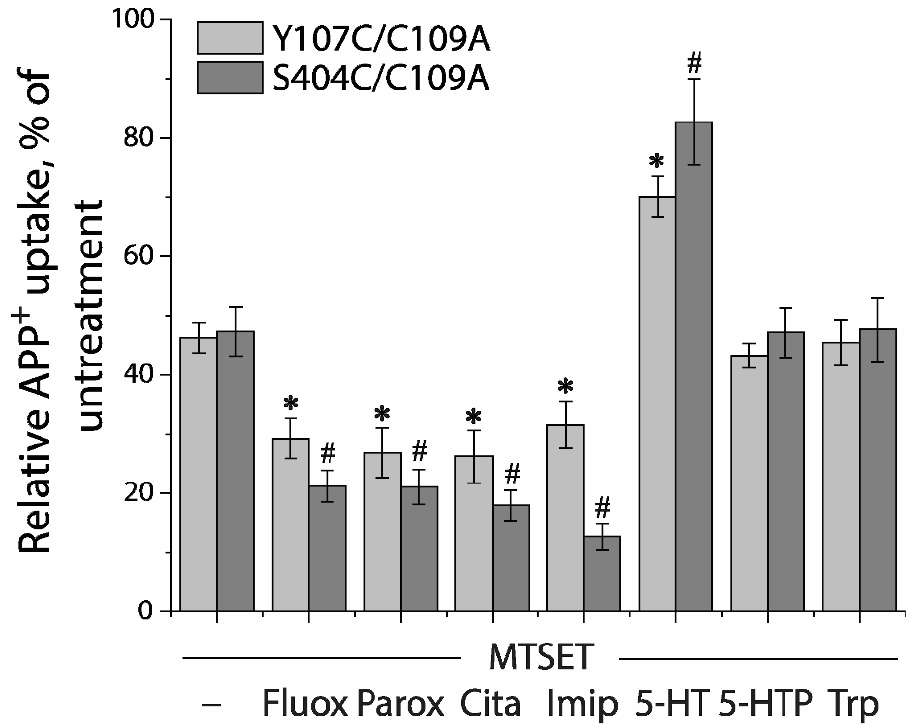
Figure 5. Ligand-induced accessibility changes in the extracellular pathway. The cells stably expressing Y107C/C109A or S404C/C109A were preincubated with indicated ligands and MTSET at a concentration of 0.01 mM for Y107C/C109A or 0.002 mM for S404C/C109A at 22 °C for 15 min, respectively. At the end of this incubation, cells were washed free of MTSET and ligands into KRH buffer containing NaCl and APP + . APP + uptake was measured as described under “Materials and Methods”. Error bars represent SEM from three experiments. Asterisks and hashtags indicate statistically significant changes ( p < 0.05) in the accumulated APP + fluorescence compared with the corresponding control (MTSET alone). Fluox, fluoxetine; Paro, paroxetine; Cita, citalopram; Imip, imipramine; 5-HTP, 5-hydroxytryptophan; Trp, L-tryptophan.